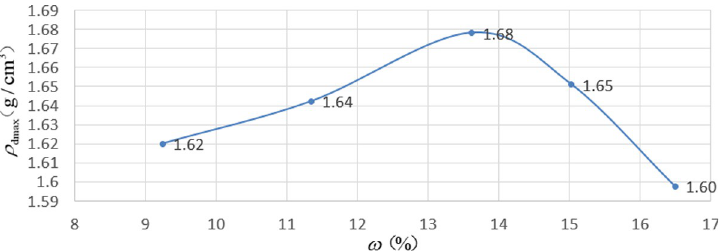
Fig 5. Compaction curve of carbide slag solidified soil. According to the experiment, the optimum moisture content of 2:8 carbide-slag-solidified soil was 13.62%, and the maximum dry density was 1.68g/cm 3 .